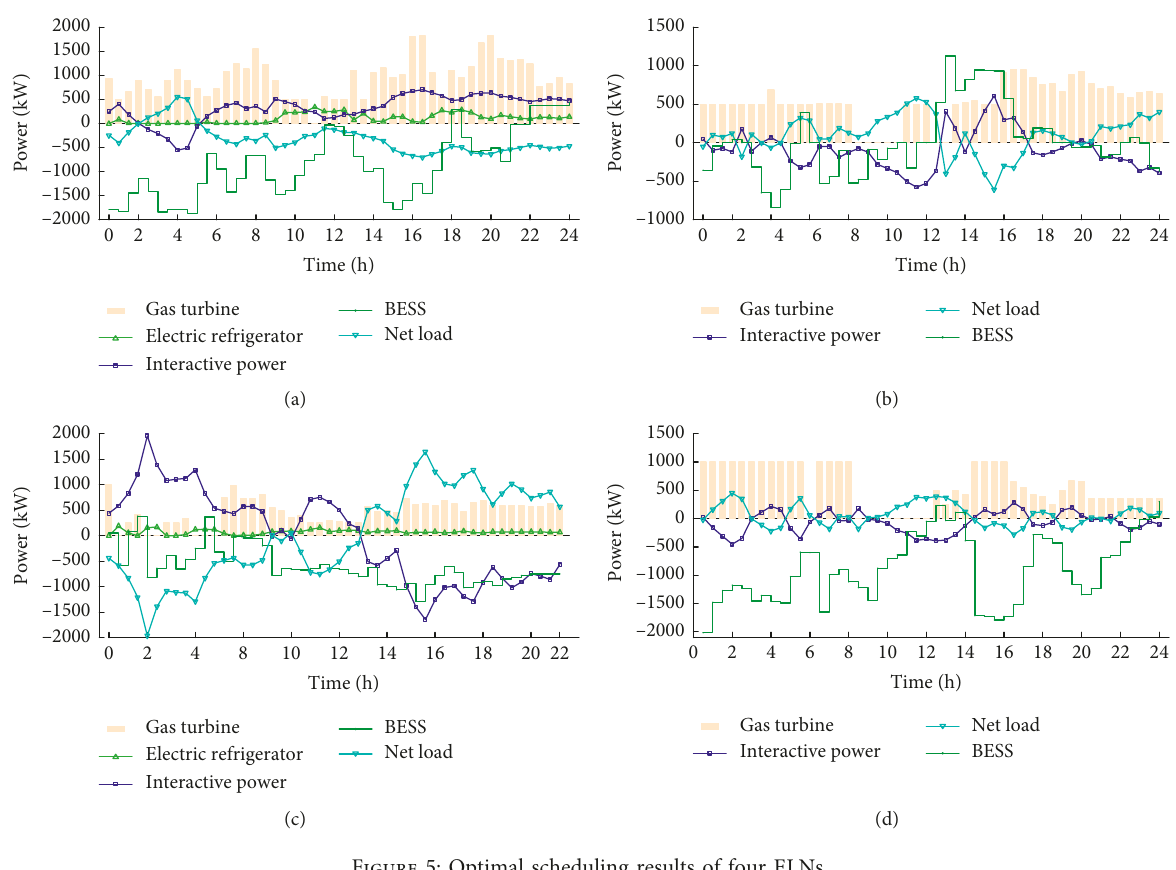
Figure 5: Optimal scheduling results of four ELNs.